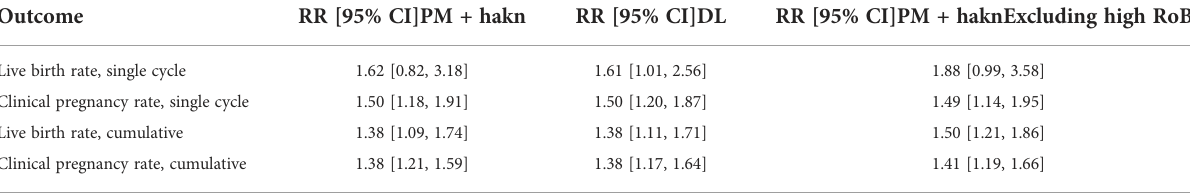
TABLE 2 Sensitivity